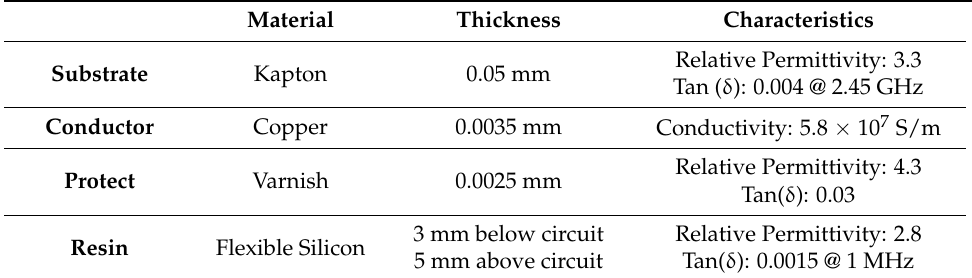
Table 7. Optimized parameter values of the proposed antenna .